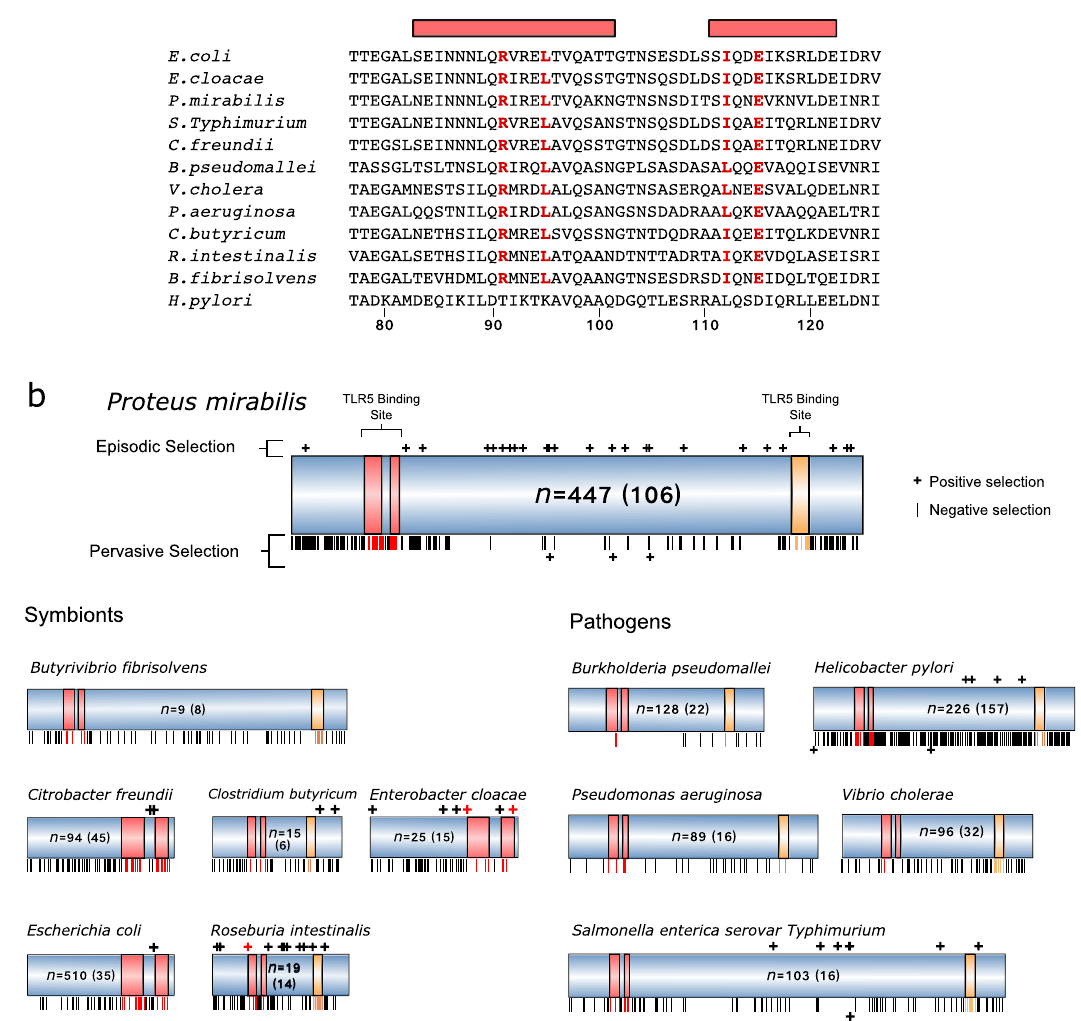
agellin which TLR5 recognises in symbionts and pathogens. Red bars indicate residues predicted to be in the interface between fl agellin and TLR5 74 .